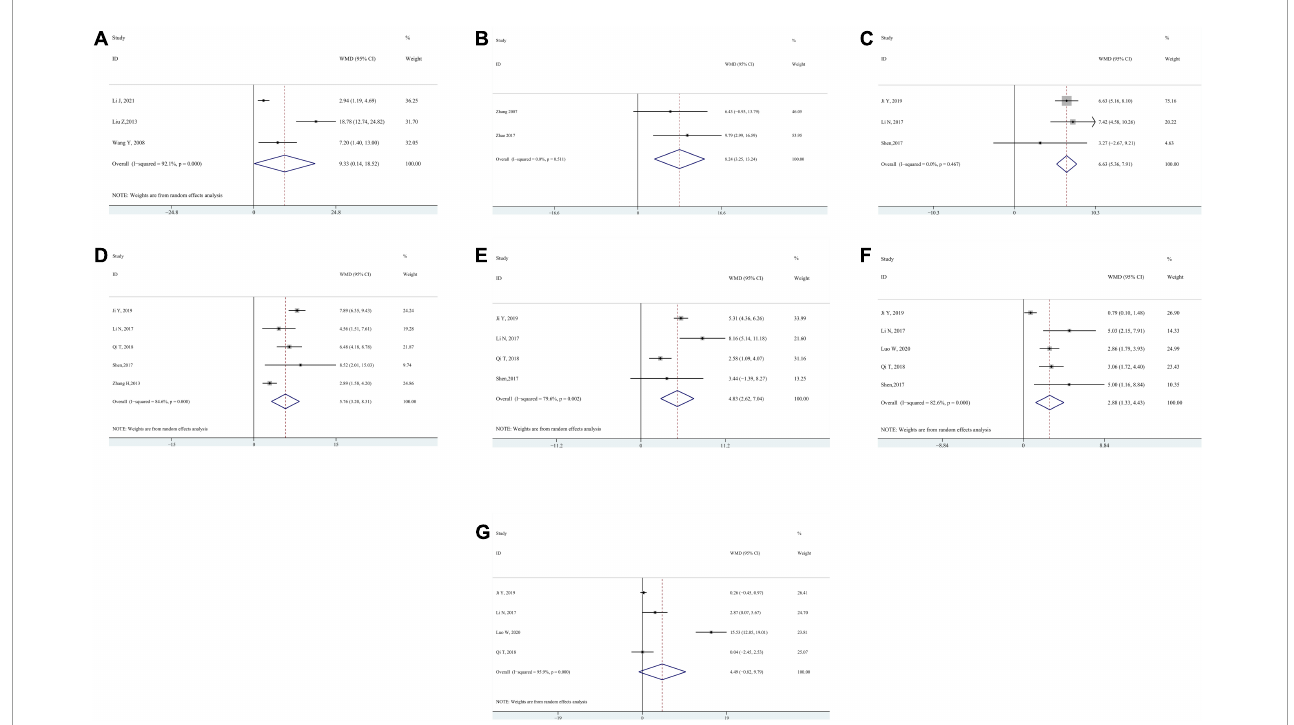
FIGURE2 Forest plot of pooled results for gross motor function measure (GMFM) (A) GMFM–66. (B) GMFM–88. (C) GMFM–88–Dimension A. (D) GMFM–88–Dimension B. (E) GMFM–88–Dimension C. (F) GMFM–88–Dimension D. (G) GMFM–88–Dimension